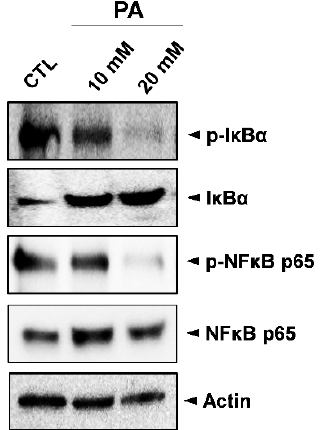
Figure 5. Inhibition of the NF- κ B signaling pathway in HeLa cells by PA. Whole cell lysates were used to determine the expression levels of I κ B α , p-I κ B α (Ser32), NF κ B p65, and p-NF κ B p65 (Ser536) after treating cells with 10 mM and 20 mM PA for 48 h.